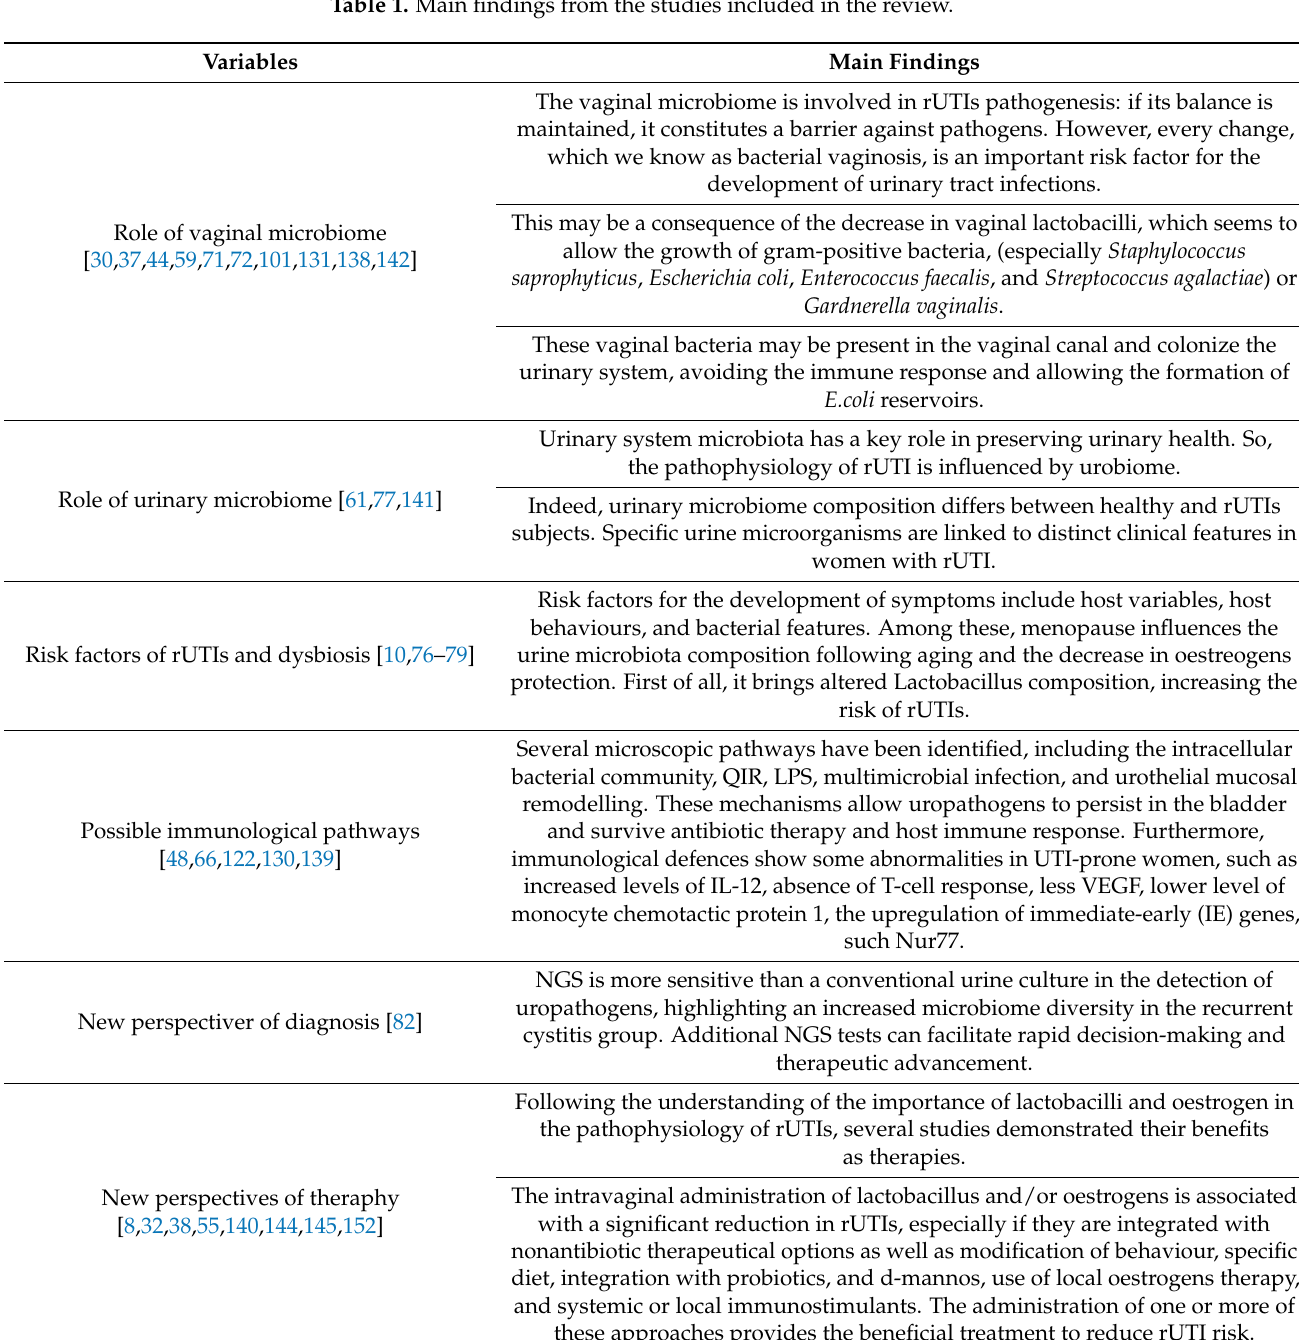
Table 1. Main findings from the studies included in the